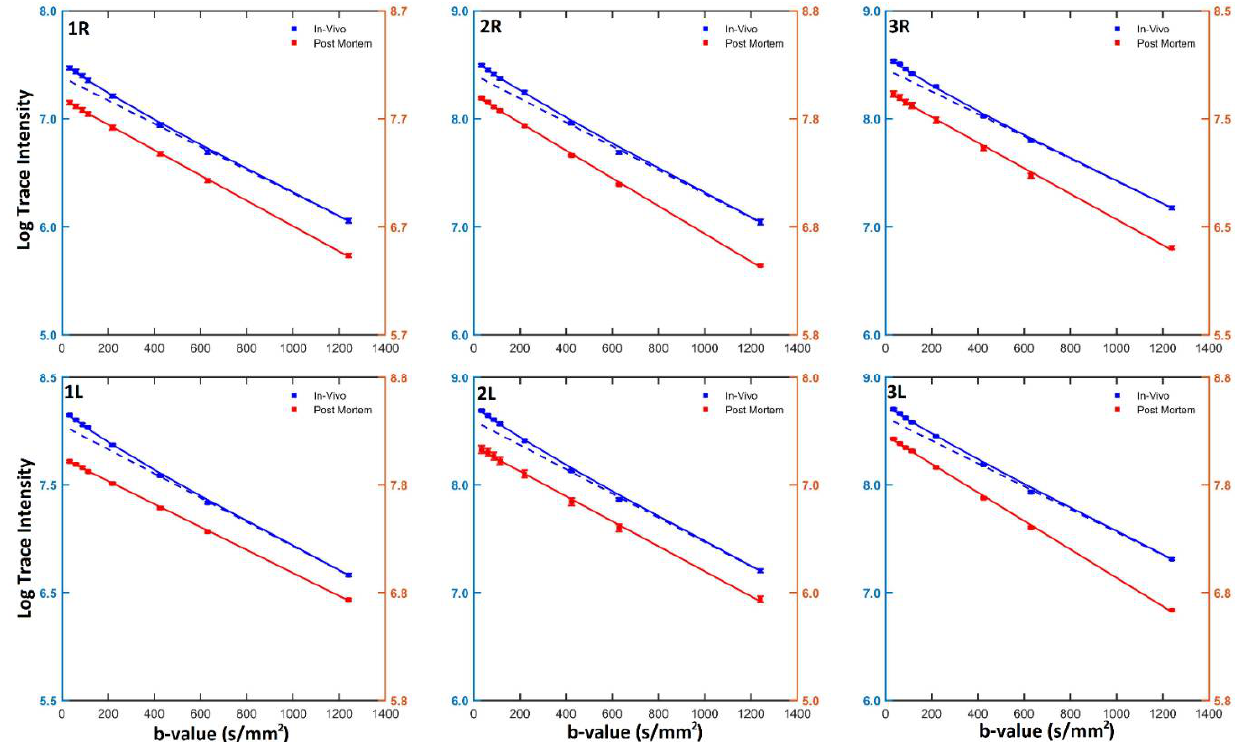
Figure 2. Diffusion signals in the rat sciatic nerve. The ROI-averaged trace-weighted diffusion signals obtained both in vivo (blue) and postmortem (red, with scales indicated to the right of the graphs) in the right ( top row ) and left ( bottom row ) sciatic nerves of all animals ( columns ) are plotted on a logarithmic scale as a function of the b-value. The solid lines denote the bi-exponential and single-exponential fits of the in vivo and postmortem data, respectively. The blue dashed lines are single-exponential fits of the in vivo data with b -value ≥ 400 s/mm 2 and are extrapolated to lower b-values. Error bars represent standard errors of ROI mean. Table 1. Tensor-derived quantities of the in vivo and postmortem diffusion signals, with the in vivo signal separated into fast and slow